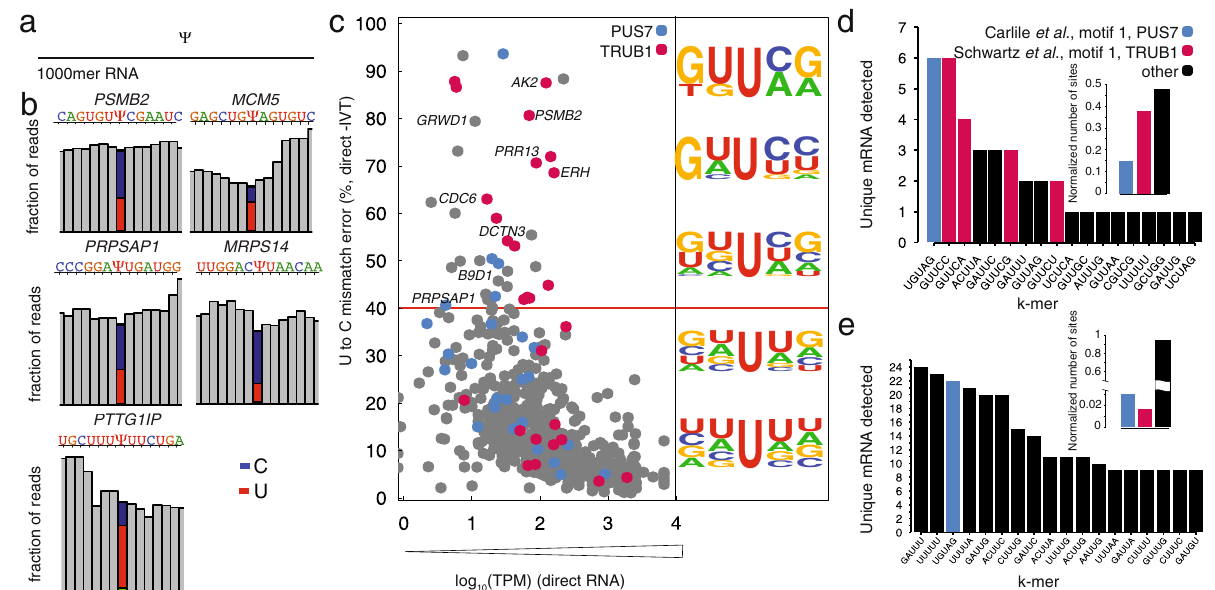
Fig. 5 | Solid-phase synthesis of 1000mer RNA standards that maintain the sequence context of putative ψ sites demonstrates a systematic undercalling ofthemodi fi cation.a Apairof1000-mersyntheticRNAoligosweredesigned,one containing 100% uridine and the other containing 100% ψ in the sequencecontext of a natural transcript. b The frequency histograms of 13 nucleotides surrounding the detected ψ position in the middle of a k-mer in four different mRNAs: PSMB2 , MCM5 , PRPSAP1 , and MRPS14, and PTTG1IP . c The U-to-C mismatches of the